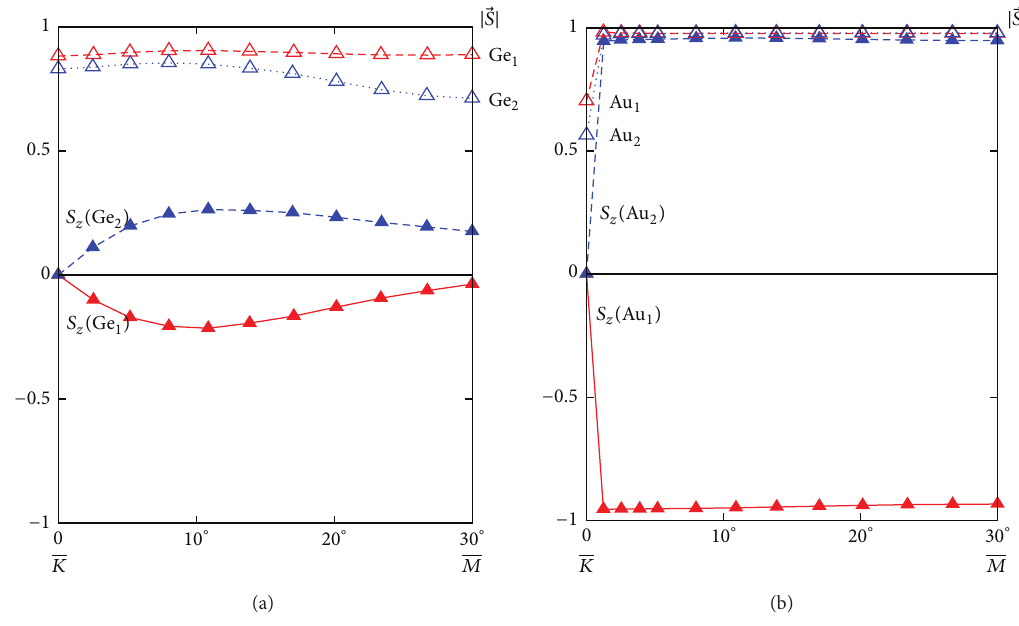
Figure 8: 𝑆 𝑧 components of spin vectors (filled triangles) along one arc of the bands between the Γ − 𝐾 and Γ − 𝑀 directions as a function of the scan angle, as well as the total spin polarization | contours of Figure 6 and (b) Au-like contours of Figure